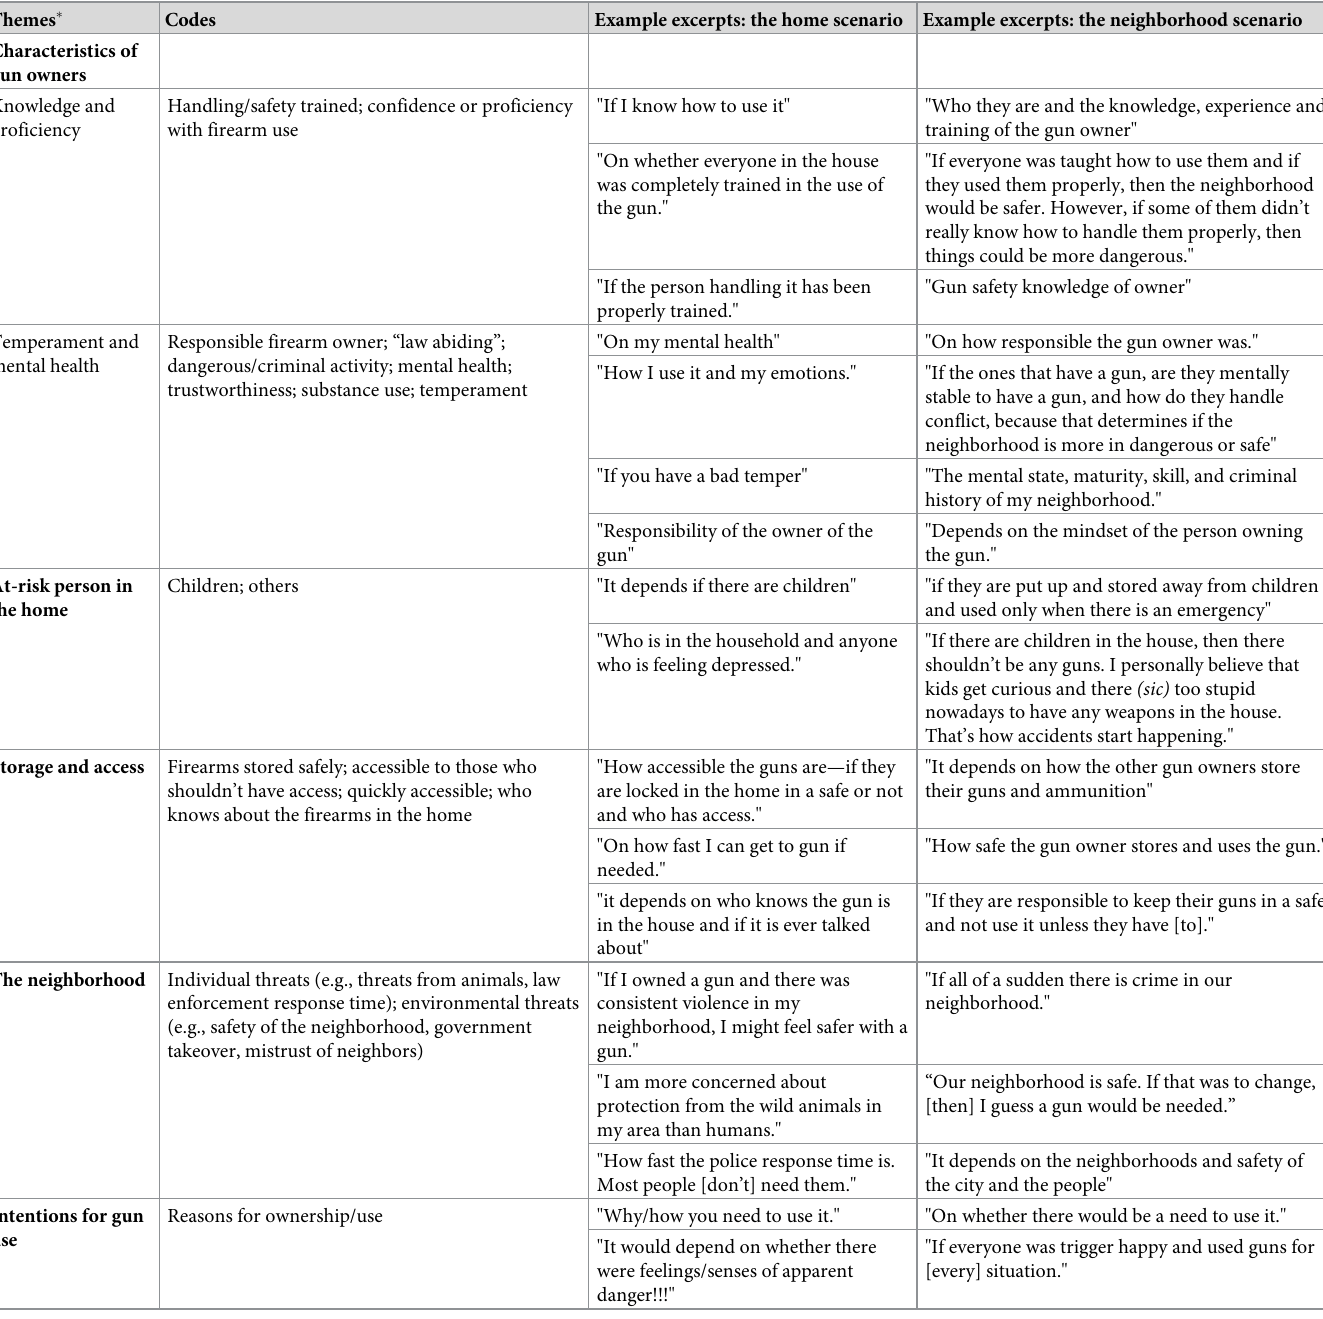
Table 3. Themes, codes, and sample of excerpts for factors on which perceived safety of guns in the home depends, by home and neighborhood scenarios. Themes